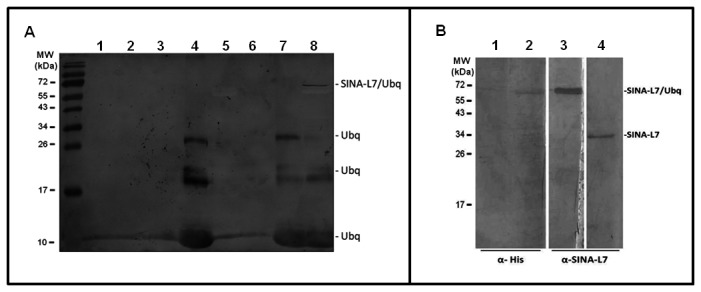
AtSINAL7 E3 ligase activity and identification of self-ubiquitinated AtSINAL7.
(A) E3 ligase activity of AtSINAL7.
In vitro self-ubiquitination reactions were performed using cMyc-ubiquitin as a substrate as described in the Methods section. Lane 1: Ubiquitination buffer. Lane 2: Ubiquitination buffer + E1. Lane 3: Ubiquitination buffer + E2. Lane 4: Ubiquitination buffer + cMyc-ubiquitin. Lane 5: Ubiquitination buffer + AtSINAL7. Lane 6: Ubiquitination buffer + E1 + E2. Lane 7: Ubiquitination buffer + E1 + E2 + cMyc-ubiquitin. Lane 8: Ubiquitination buffer + E1 + E2 + cMyc-ubiquitin + AtSINAL7. AtSINAL7/ubiquitin conjugates were resolved by electrophoresis on 15% (w/v) SDS-PAGE and detected by immunoblot analysis using anti-cMyc antibody. (B) Identification of self-ubiquitinated AtSINAL7. AtSINAL7/ubiquitin conjugates were electrophoresed on 15% (w/v) SDS-PAGE and detected by immunoblot analysis using anti-HIS (Qiagen) and polyclonal anti-AtSINAL7. Lane 1: Control containing the ubiquitination assay buffer alone. Lane 2 and 3: purified His-AtSINAL7 incubated in the complete ubiquitination reaction medium containing the cMyc-ubiquitin substrate and the yeast E1 and UbcH2 E2 components. Lane 4: purified His-AtSINAL7 alone. MW (kDa), PageRuler Prestained Protein Ladder (Fermentas).